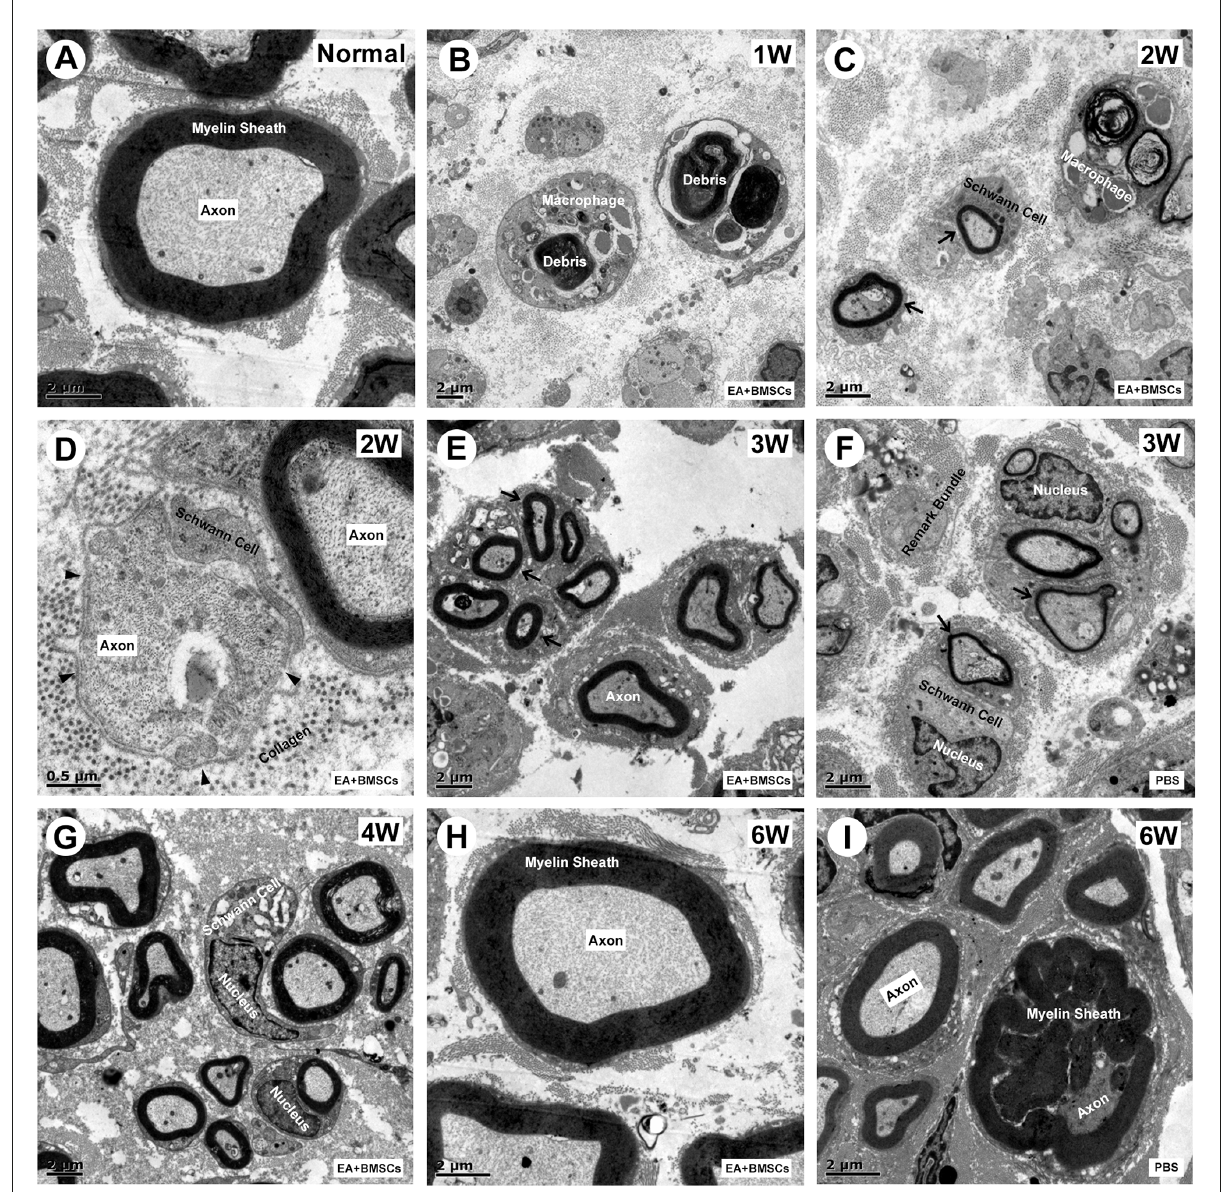
FIGURE5 Transmission electron microscopy (TEM) images of cross-sections of the sciatic nerve. (A) Cross-section of a myelinated axon of a normal adult mouse sciatic nerve. The central axon (Ax) is surrounded by the myelin sheath (MS), with a thickness of 1.2 to 2 µ m. (B) At 1-week post- operation, the myelin sheath became creased, strangled, and fell off into fragments. Massive myelin debris was phagocytosed and cleared by the macrophages. (C,D) Most debris was cleared at 2 weeks post-operation. The Schwann cells thrived, and their synapses wrapped around the axons to form new myelin sheaths, which were thin in myelin sheaths ( < 0.5 µ m; black arrow) and small in diameter. In addition, some unmyelinated fibers (black arrowhead) could be seen, with surrounding collagen tissue serving as a scaffold for the extension and winding of Schwann cells during myelin formation (D) . (E,G) During the period from 3 to 4 weeks after surgery, the number of myelinated nerve fibers, myelin thickness, and the degree of maturity of regenerating nerve fibers in EA + BMSCs group were superior to that in the PBS group (F) . (H,I) At 6 weeks post-operation, nerve fibers of EA + BMSCs group (H) recovered with regenerated axons and myelin sheaths comparable to those of the normal nerves (A) , as well as superior fiber diameter and myelin thickness to that of the PBS subgroup (I) . Some malformed regenerated fibers were observed in the PBS subgroup, with abnormally thickened myelin sheaths that are convex in the lumen. The axons are compressed and narrow.